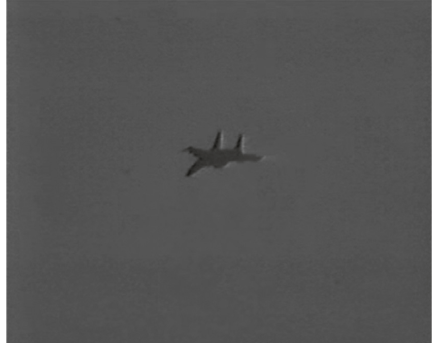
Figure 12: The base image required for the verification experiment of Figure